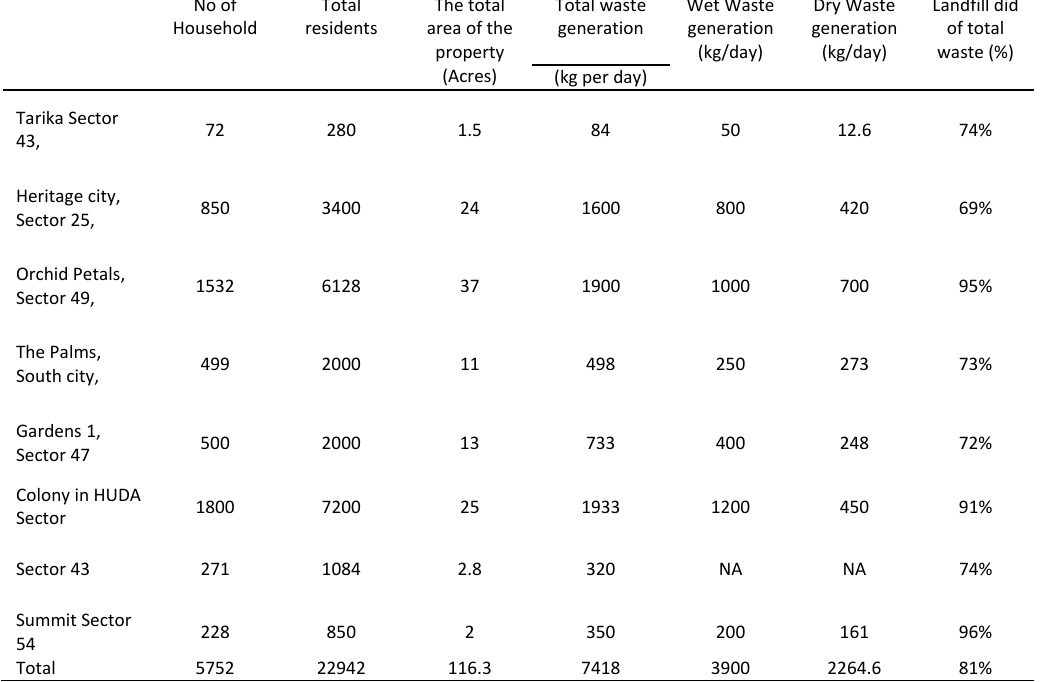
Table 2: Waste generation details of Gurugram